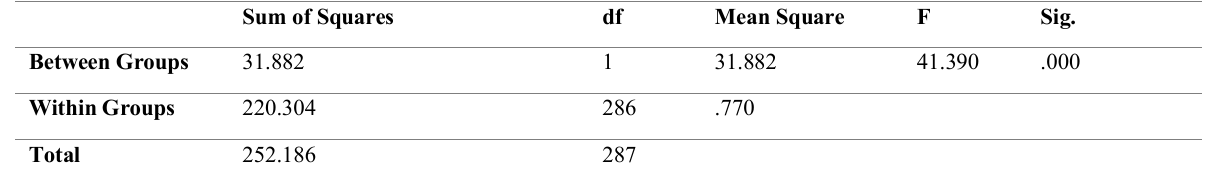
Table 2: ANOVA of Leadership development with respect to developmental efficacy